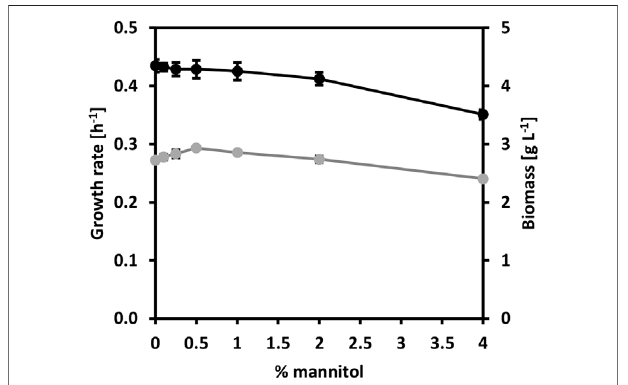
FIGURE 2 | Growth behavior of strain CgSW9 in the presence of mannitol. Glucose-based minimal medium was supplemented with gradually increasing concentrations of mannitol. Growth rate values are depicted in grey. Biomass values are depicted in black. Means and standard deviations of triplicates are